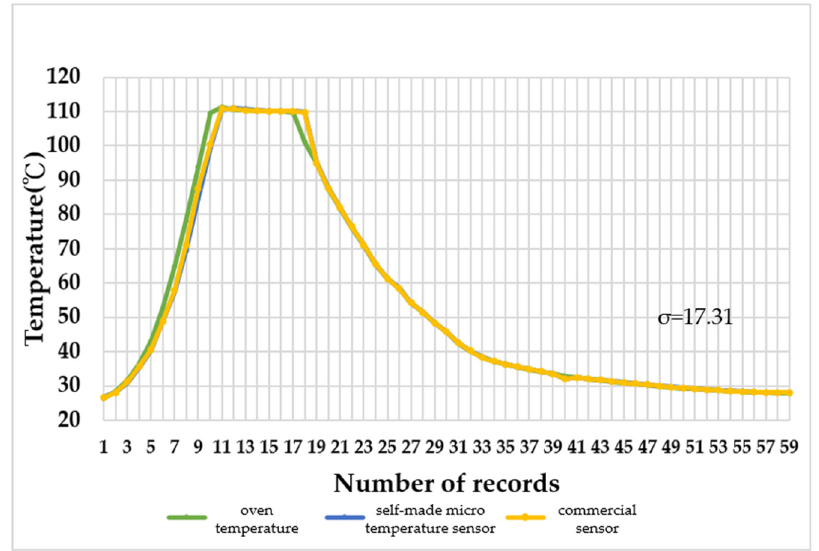
Figure 10. Monitoring data on temperature.